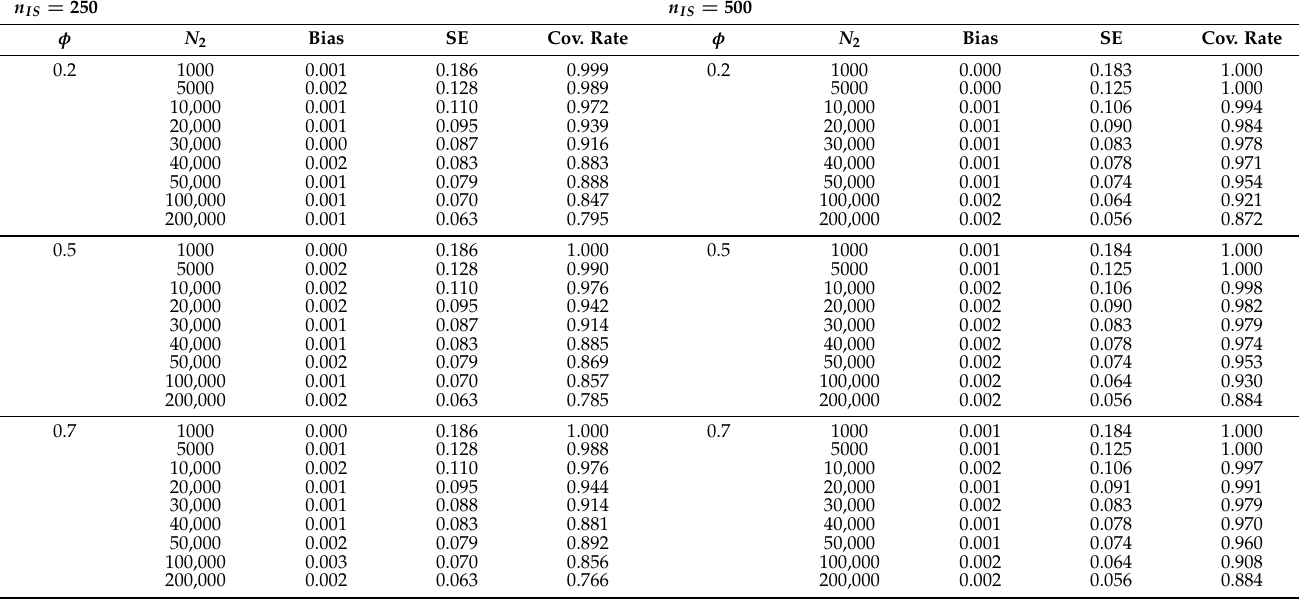
Figure 10. Bias, standard error, and coverage rate for the real case, according to the ratio and φ . Blue points n IS = 250, green points n IS = 500. Table 4. Bias, standard errors, and coverage rates of the inverse sampling estimates of the real case, according to the bias, dataset size, and extracted subsample